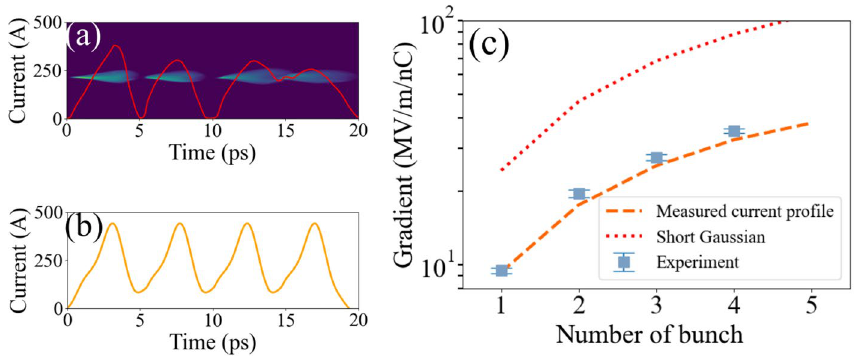
Figure 7. Scaling of achievable gradient from the fabricated structure. Gradients for bunch train were measured up to four bunches (blue-dot, panel c ), and the corresponding measured current profile is in panel ( a ). “Measured profile” case (red-dash) in panel ( c ) shows the simulated achievable gradient. For this simulation, the measured current profile for a single bunch was duplicated as given in panel ( b ). “Short Gaussian” case (red-dot) in panel c shows the simulation with a short Gaussian that provides the bunch form factor of